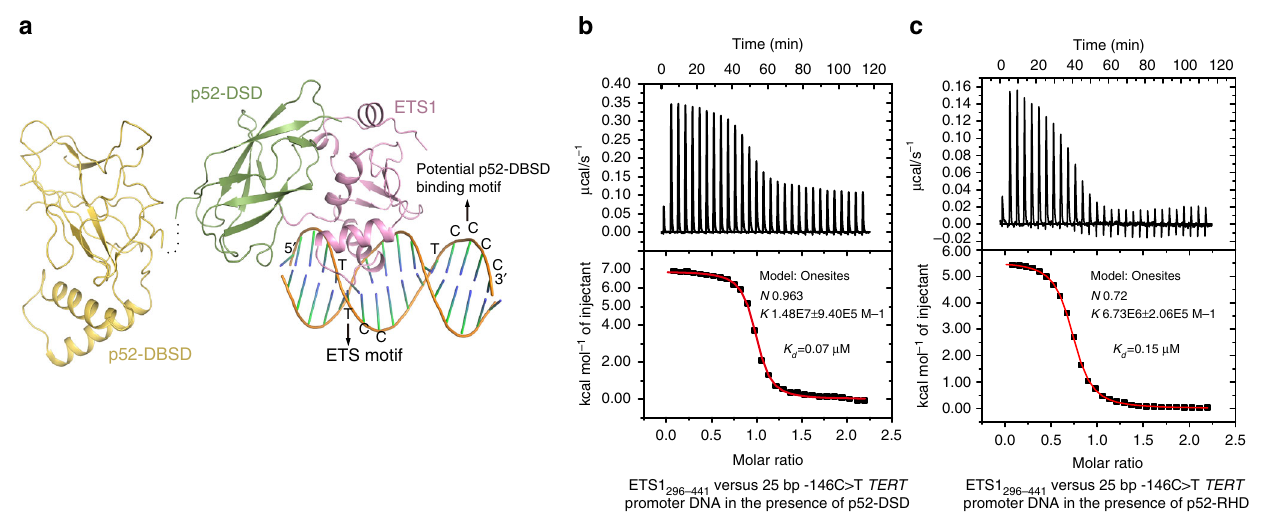
Fig. 3 p52 does not speci fi cally bind to − 146C>T TERT promoter. a A model showing that p52 would not bind to − 146C>T TERT promoter speci fi cally. The relative orientation between p52-DSD and p52-DBSD showed here is the same as that in the structure of p52 homodimer in complex with DNA (PDB code: 1A3Q). b , c ITC titrations of ETS1 296 – 441 and a 25 bp − 146C>T TERT promoter DNA in the presence of p52-DSD ( b ) or p52-RHD ( c